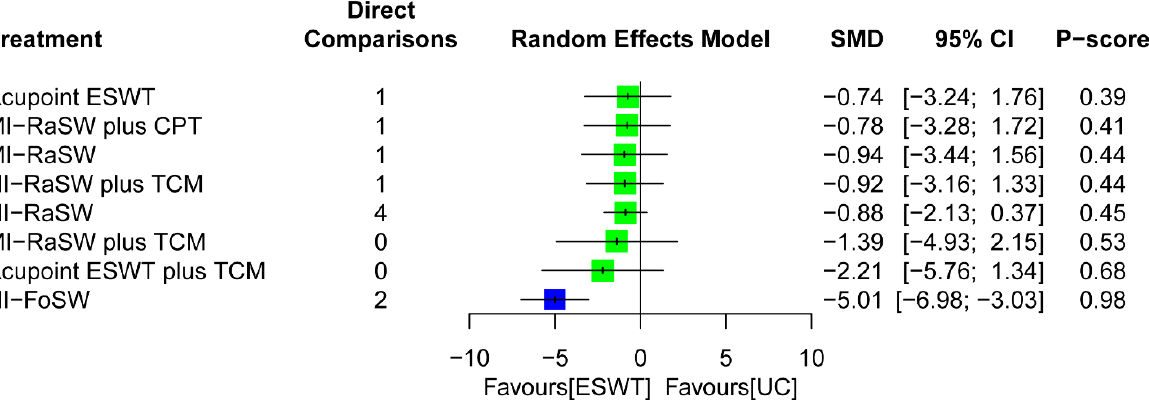
Figure 5. Forest plot summarizing the effects of treatment regimens of ESWT on disease inflammation for the overall follow-up duration. The blue point denotes the highest rank of probability, indicating that the treatment approach is the optimal intervention among all treatments. 95% CI = 95% confi- dence interval; CPT, conventional physical therapy; ESWT, extracorporeal shockwave therapy; FoSW, focused shockwave; HI, high energy; MI, medium energy; RaSW, radial shockwave; TCM, traditional Chinese medicine; UC, usual